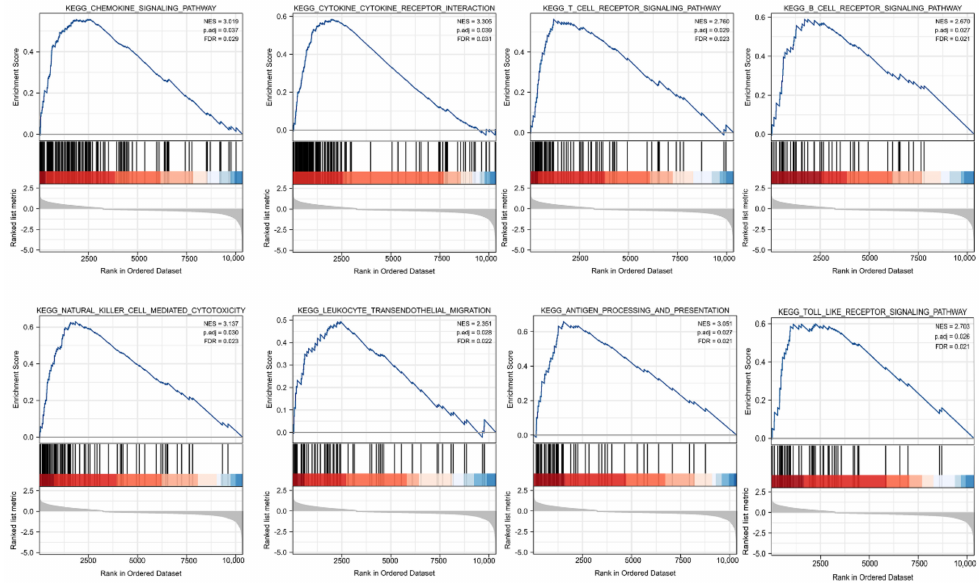
Figure 7. Identification of KCNAB2 − related signaling pathways in LUAD using